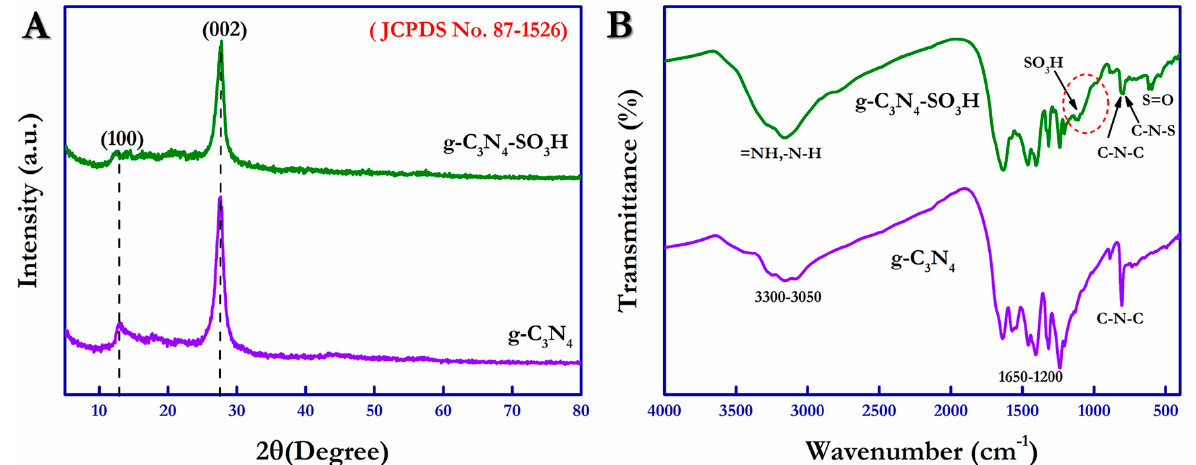
Figure 1. X-Ray diffraction spectra of g-C 3 N 4 and g-C 3 N 4 –SO 3 H ( A ) and Fourier-transform infrared spectra of as-synthesized g-C 3 N 4 and g-C 3 N 4 –SO 3 H ( B ).